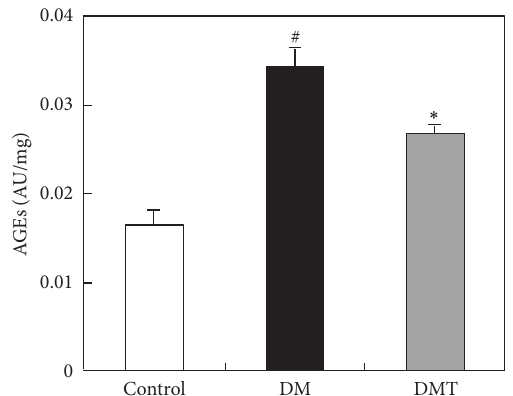
Figure 2: The effect of phlorizin on AGE levels in blood. # 𝑃 < 0.05 , and indicates a significant difference between the control and DM group; ∗ 𝑃 < 0.05 , and indicates a significant difference between the DMT and DM group ( 𝑛 = 8 ). DM: vehicle-treated diabetic group; DMT: diabetic group treated with 20mg/kg phlorizin; AGEs: advanced glycation end